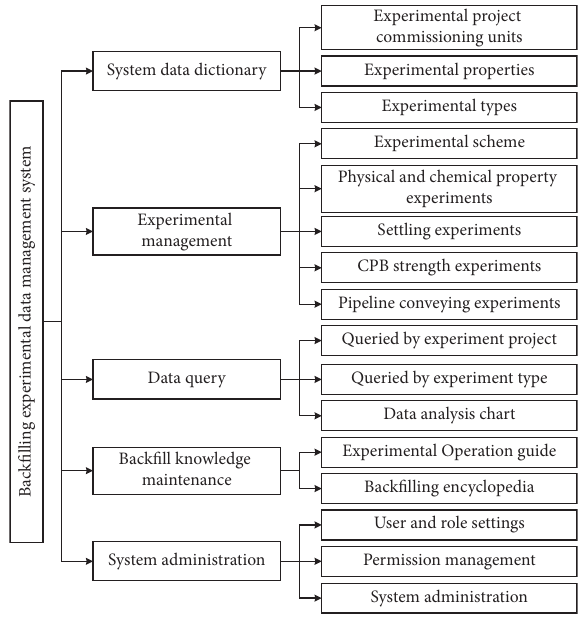
Figure 4: System function